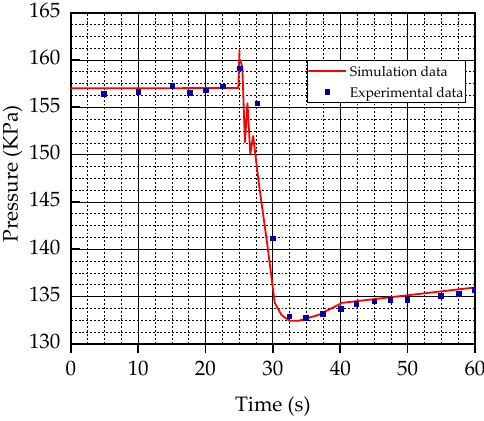
Figure 10. Bottom hole pressure vs. time.